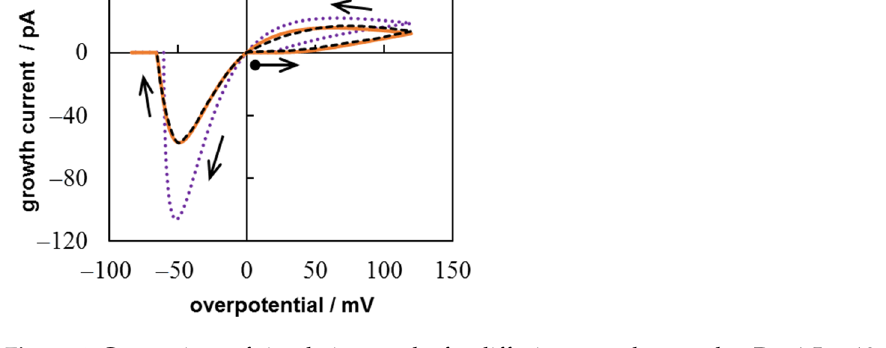
Figure 5. Calculated dependences of ( a ) the nucleus radius against overpotential and ( b ) the decimal logarithms of the contributions of the charge transfer ( R ct , solid line) and diffusion ( R d , dotted line) limitations against the nucleus radius. The symbols indicate the points, at which R ct = R d .